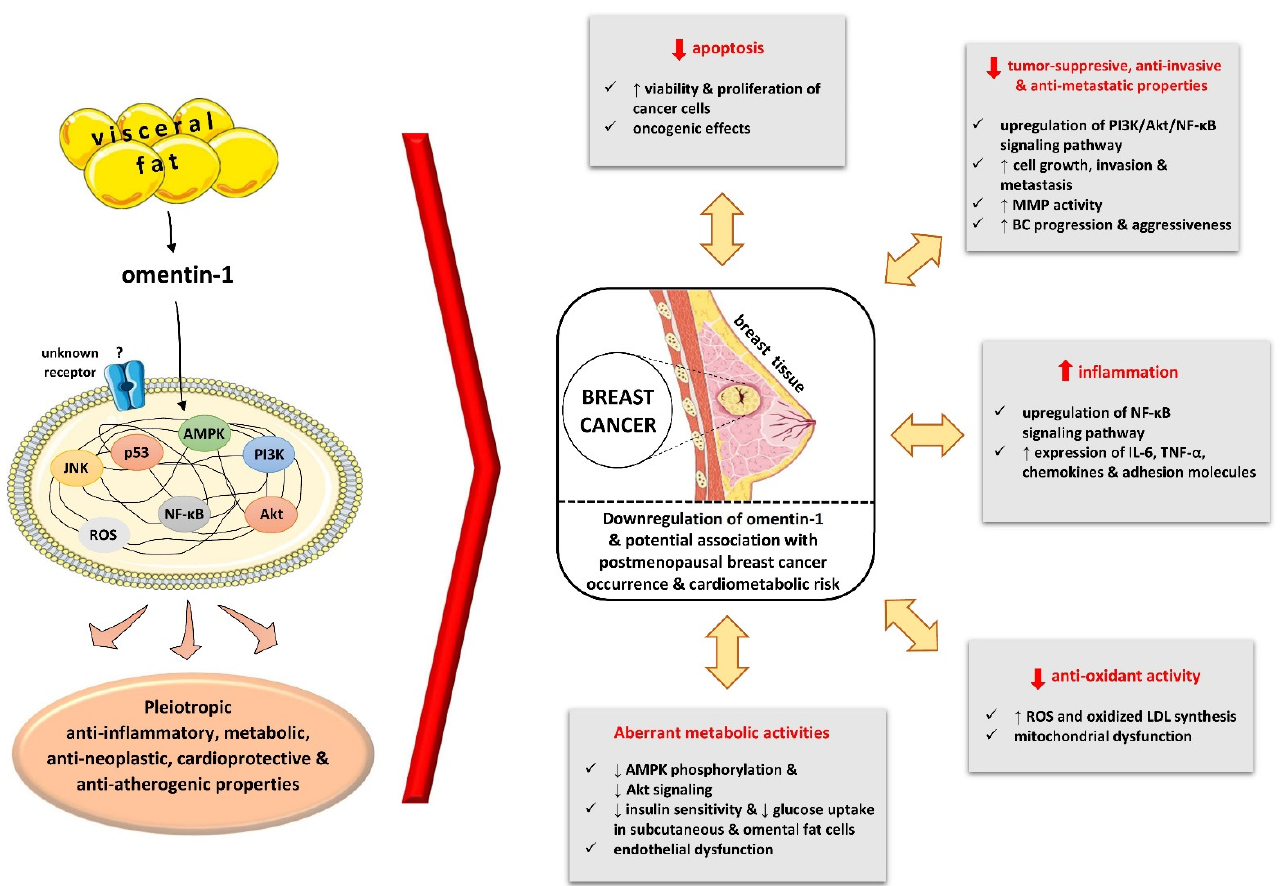
Figure 4. Aberrant expression of omentin-1 in breast cancer and potential implicated mechanisms underlying the association of its lower circulating levels with postmenopausal breast cancer occurrence and cardiometabolic risk. Abbreviations: AMPK, AMP-activated protein kinase; BC, breast cancer; IL-6, interleukin-6; LDL, low-density lipoprotein; MMP, matrix metalloproteinase; NF- κ B, nuclear factor- κ B; PI3K, phosphoinositide 3-kinase; ROS, reactive oxygen species; TNF- α , tumor necrosis factor-alpha. (All images are originated from the free medical website http://smart.servier.com/ (accessed on 3 September 2021) by Servier licensed under a Creative Commons Attribution 3.0 Unported